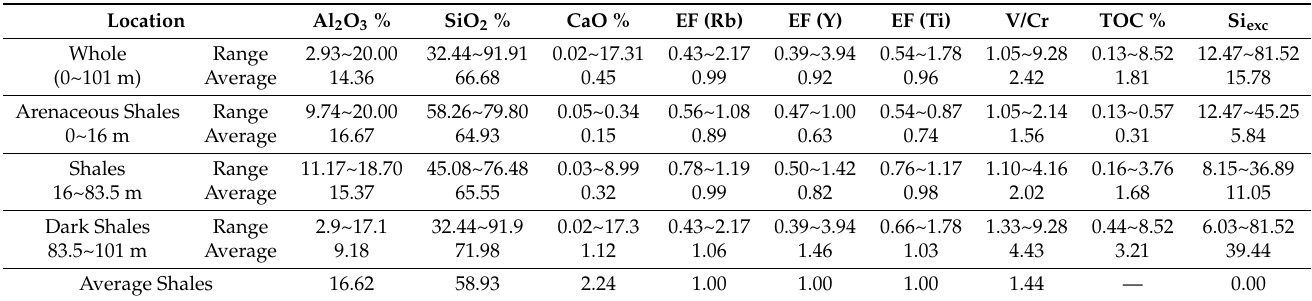
Table 1. The statistical results of geochemical proxies used in this